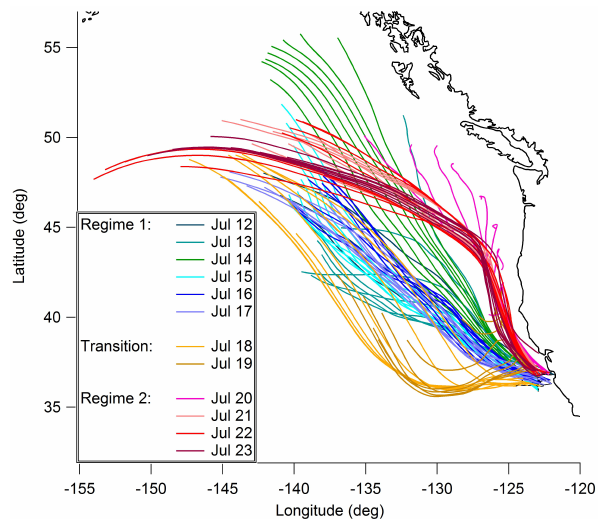
Fig. 2. Three-day HYSPLIT back trajectories (every three hours, ending altitude: 50 m) show air mass origins during the cruise. Three distinct groups of trajectories governed by synoptic condi- tions are apparent: back trajectories pertaining to Regime 1 (blue, green), Transition (orange), and Regime 2